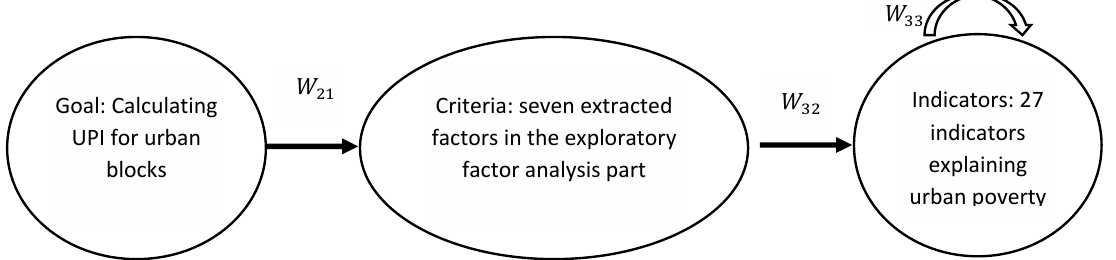
Fig. 4: External and internal relations among the indicators and the criteria